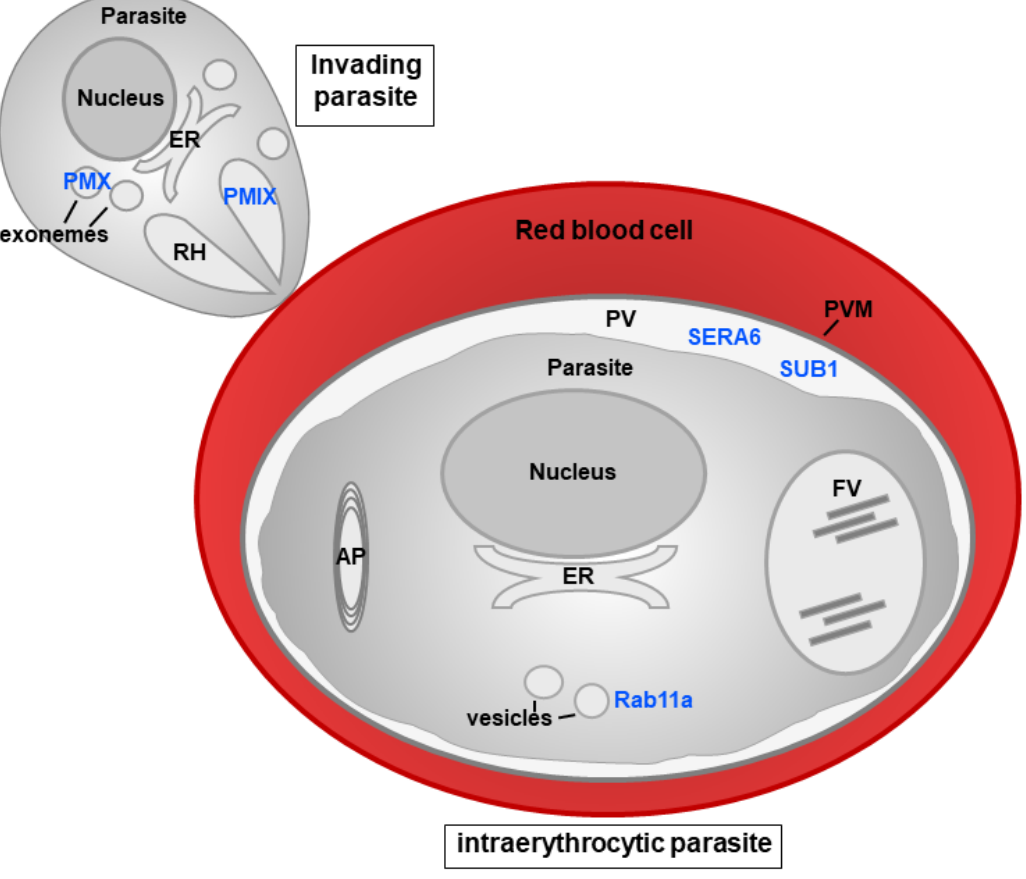
Figure 1. Localization of antimalarial targets in the asexual parasite. Shown are parasite organelles, including the nucleus, apicoplast (AP), endoplasmic reticulum (ER), food vacuole (FV), rhoptries (RH), exonemes, and vesicles. The intraerythrocytic parasite is located within the parasitophorous vacuole (PV), which is delineated by the PV membrane (PVM), where both SUB1 and SERA6 are found during egress 98 . Rab11a likely localizes to vesicles, which it guides to target membranes. In the invading parasite, plasmepsin IX (PMIX) is found in the bulbs of RH and plasmepsin X (PMX) localizes to exonemes 72